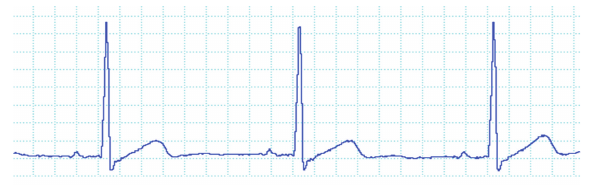
Figure 14: ECG measurements.